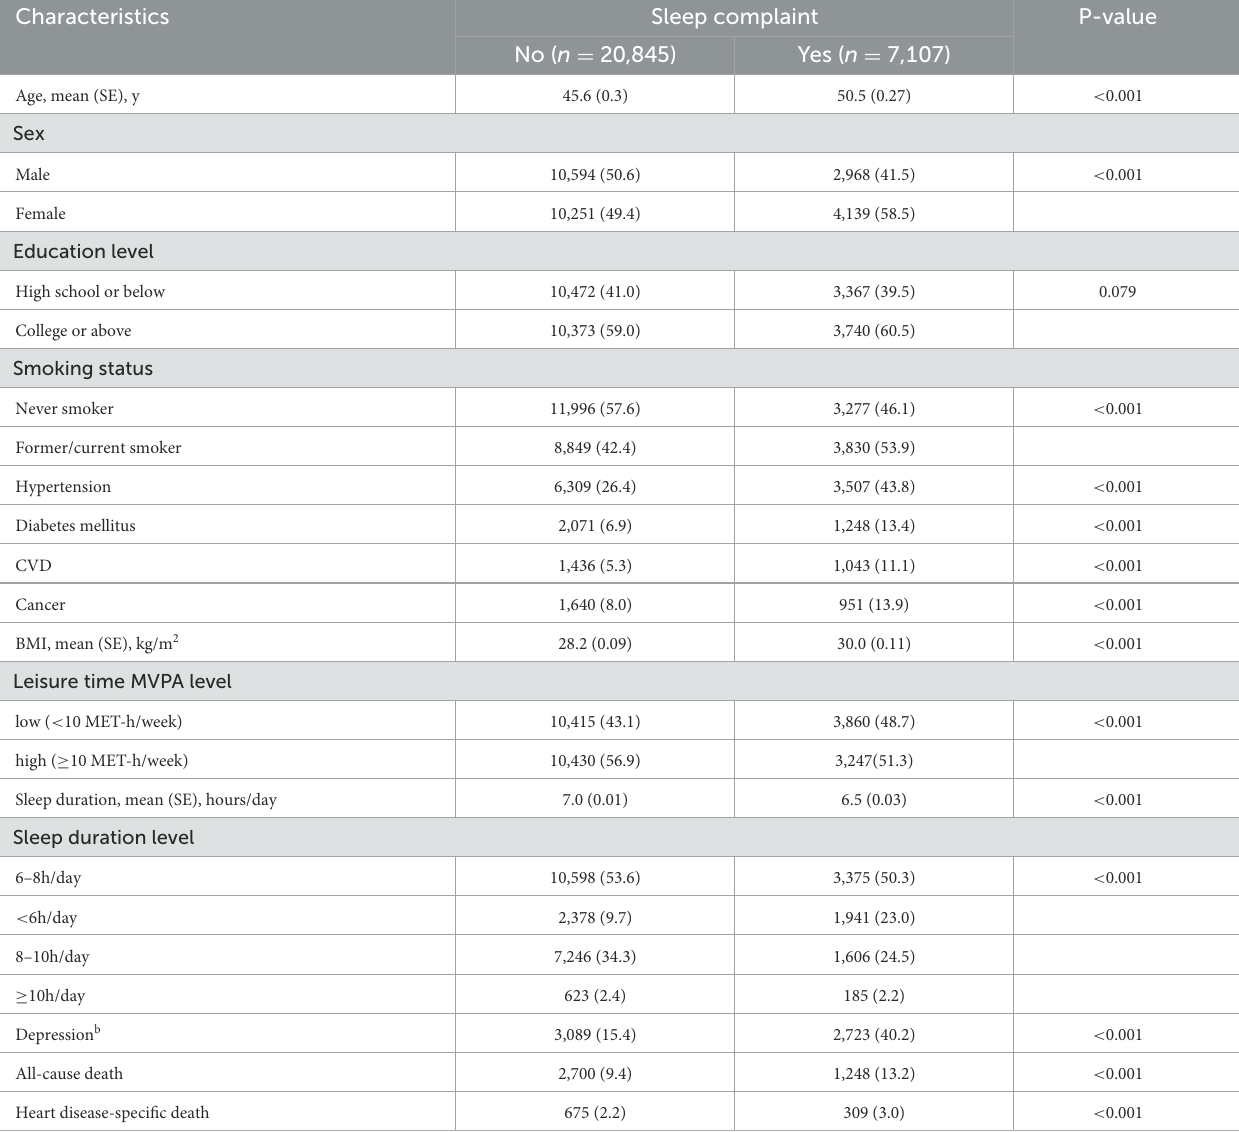
TABLE 1 Baseline characteristics of all included participants by sleep complaints from NHANES 2005 through 2014 a .